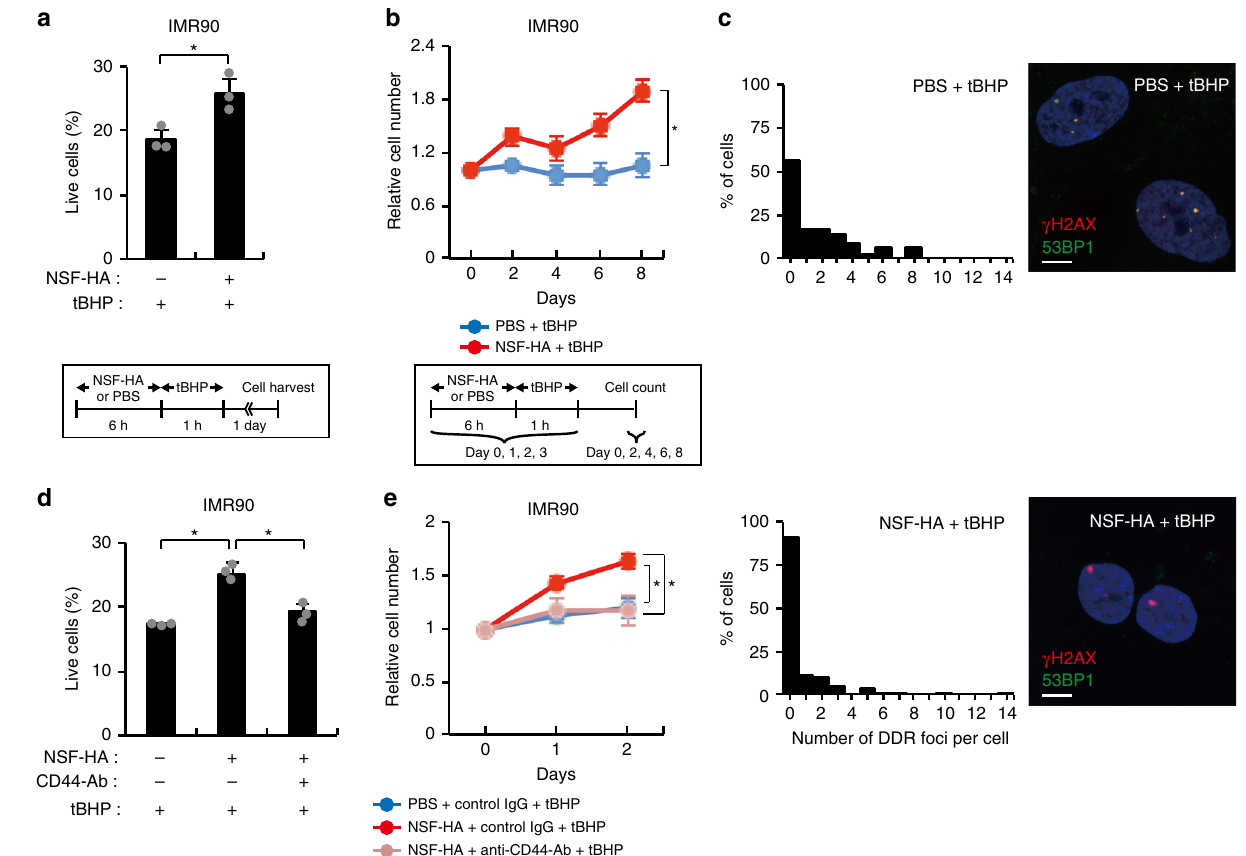
Fig. 1 The effects of NSF-HA on cellular resistance to oxidative stress. a NSF-HA suppresses oxidative stress-induced cell death in IMR90 cells. The percentages of live cells were measured by Annexin-V/PI staining 1 day after 1 h of 3 mM tBHP-treatment ( n = 3). Cells were pre-incubated for 6 h with 20 μ g/ml NSF-HA or PBS before tBHP-treatment. b NSF-HA suppresses oxidative stress-induced growth arrest in IMR90 cells ( n = 4). Cells were pre- incubated for 6 h with 20 μ g/ml NSF-HA or PBS and then HA was removed and cells were exposed to 200 μ M tBHP for 1 h. These treatments were repeated daily for the fi rst 4 days. c IMR90 cells were stained with γ H2AX and 53BP1 antibodies at day 8 of the experiment represented in ( b ). Histograms show the distributions of the number of γ H2AX/53BP1 colocalized foci per cell. For each sample group, experiment was repeated ( n = 2) and more than 100 cells were counted in total. Scale bars, 20 μ m. d CD44 antibody blocks the cytoprotective effect of NSF-HA on oxidative stress-induced cell death in IMR90 cells. The percentages of live cells were measured by Annexin-V/PI staining 1 day after 1 h of 3 mM tBHP-treatment ( n = 3). Cells were pre- incubated for 6 h with 20 μ g/ml NSF-HA or PBS with or without CD44 blocking antibody (10 ng/ml) before tBHP-treatment. e CD44 antibody blocks the cytoprotective effect of NSF-HA on oxidative stress-induced growth arrest in IMR90 cells ( n = 4). Cells were pre-incubated for 6 h with 20 μ g/ml NSF-HA or PBS with or without CD44 blocking antibody (10 ng/ml) and then HA was removed and cells were exposed to 200 μ M tBHP for 1 h on day 0 and day 1. Scale bars, 20 µ m. Error bars are presented as mean ± SD values. * p < 0.05 [two-tailed t -test for ( a , b ) and one-way ANOVA with post-hoc Dunnett ’ s